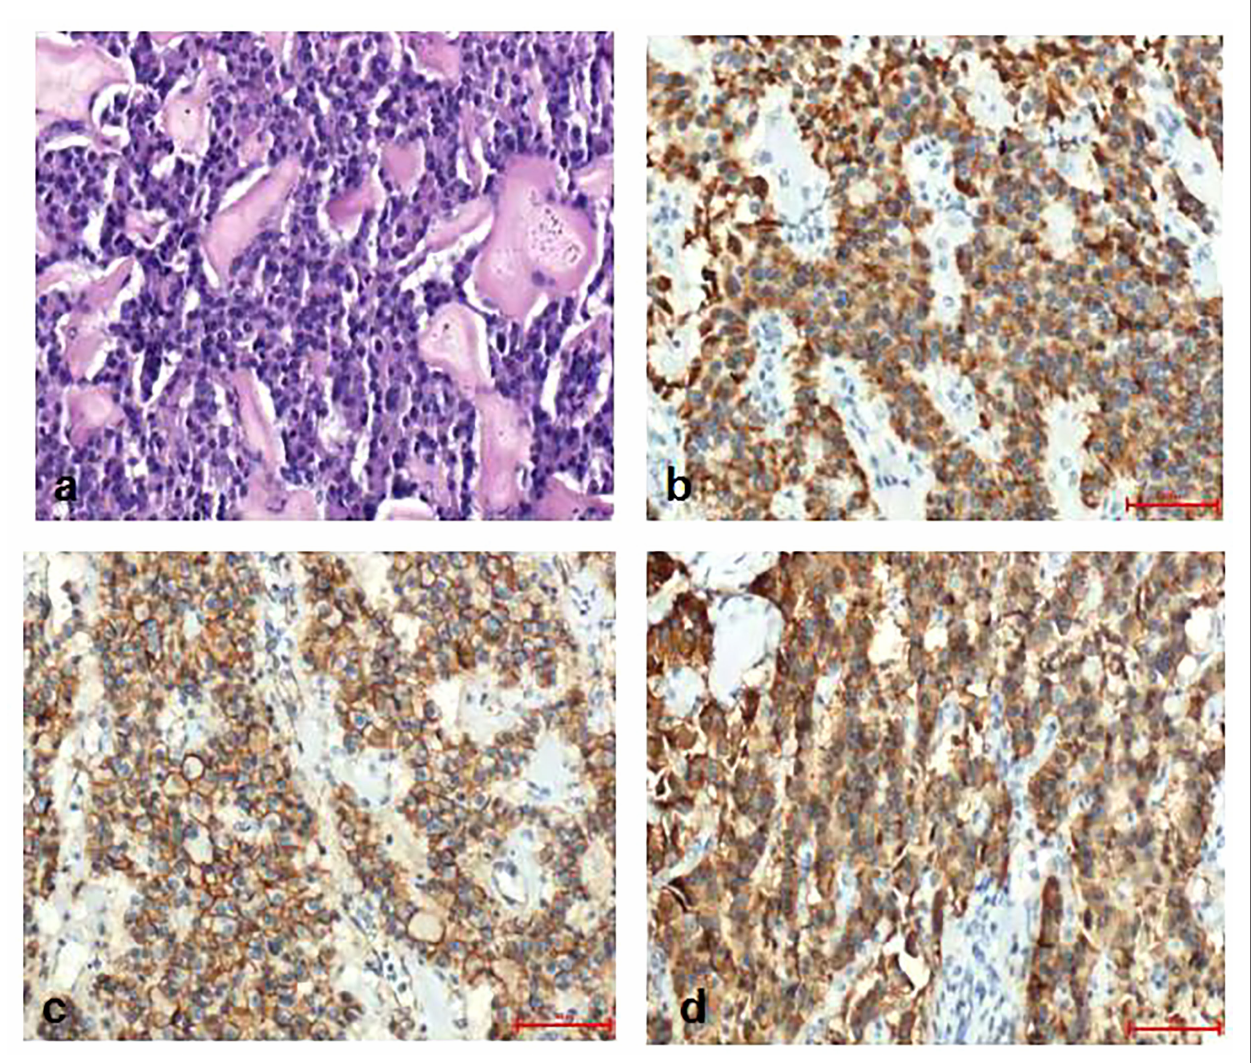
FIGURE 3 | Pathology result of the pancreas. (A) Pancreatic tumor cells were mostly distributed in strips or diffuse sheets, with the same cell size; (B) Immunohistochemistry CK(PAN)(+); (C) Immunohistochemistry SY(+); (D) Immunohistochemistry beta -Catenin (cell